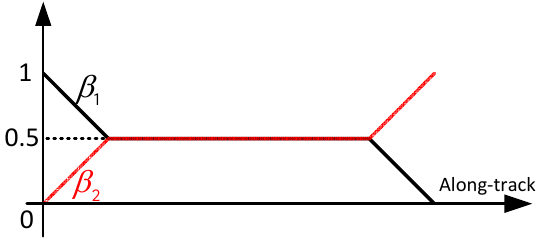
Figure 7. The β 1 , β 2